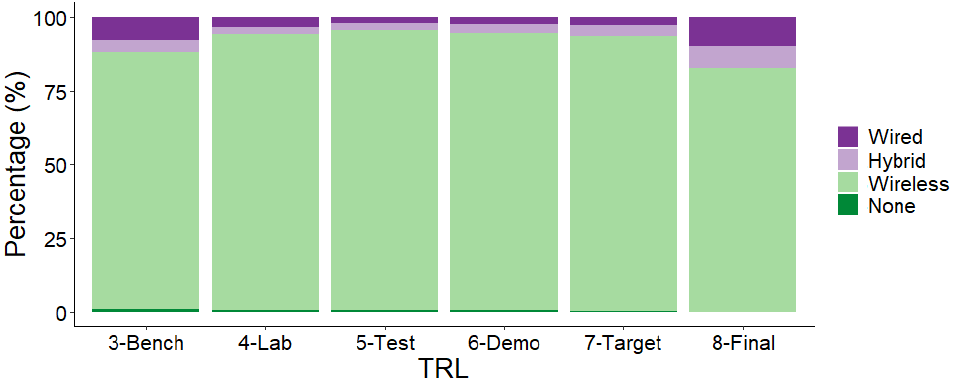
Figure 6. Deployment distribution between TRL and node connection type.